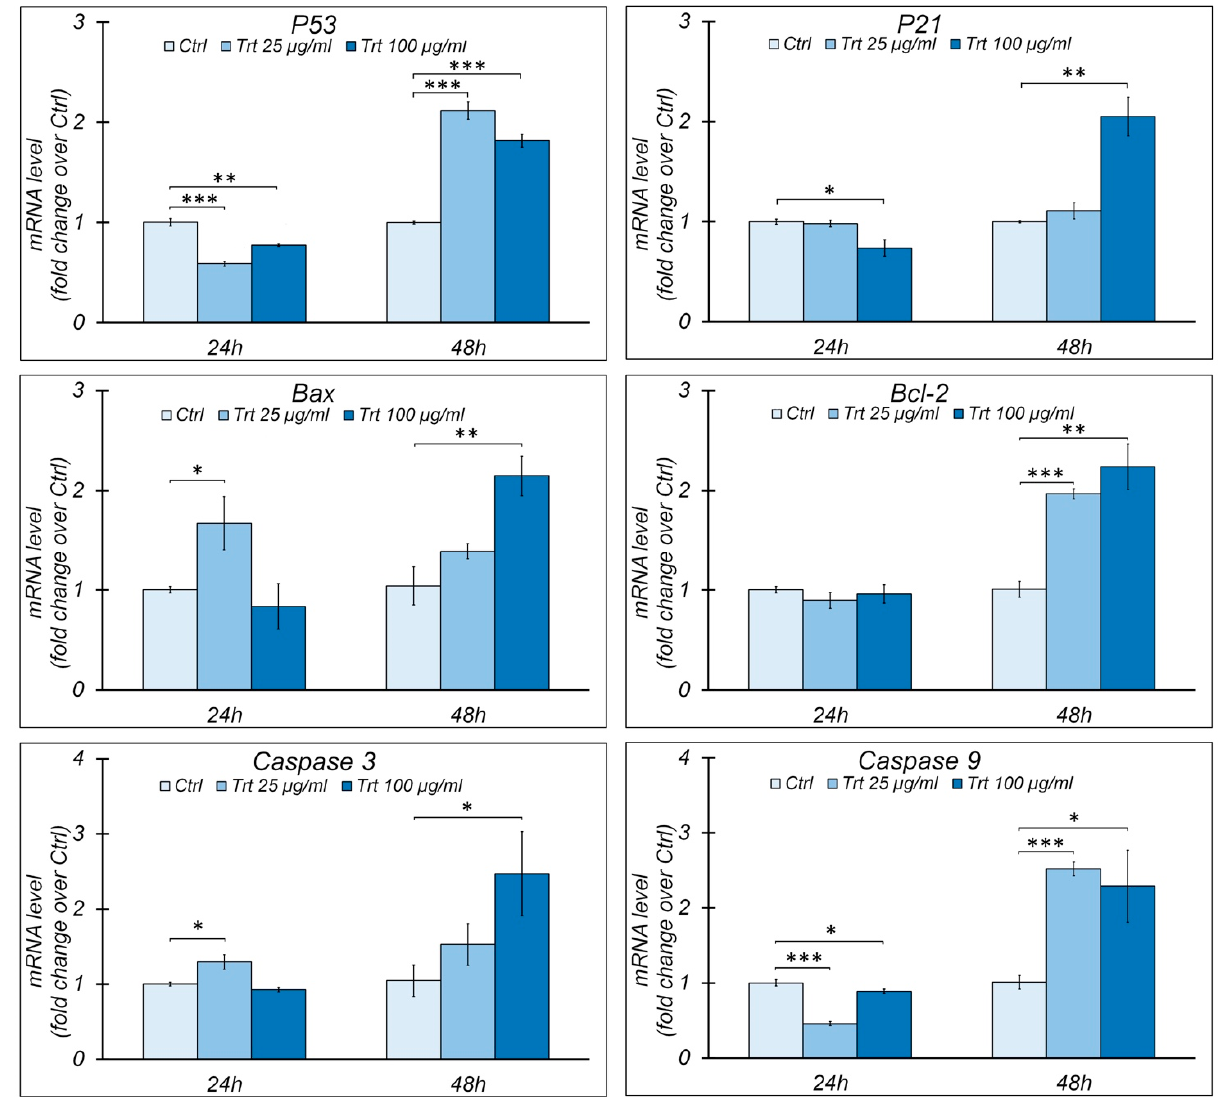
Figure 3. Gene expression by RT-qPCR. Analysis of gene expression by RT-qPCR of p53, p21, Bax, Bcl-2, caspase 3, and caspase 9 in RAW cells, treated (Trt) or not (Ctrl) for 24 or 48 h with 25 or 100 μ g/mL of passenger tire wear particles. Histograms show the relative mRNA level, normalized to endogenous control Gapdh and expressed as fold change over control. Means ± S.E.M. are reported (n = 4). Student’s t test was employed to compare the values of untreated (control) and treated cells. * p < 0.05; ** p < 0.005; *** p < 0.0005.